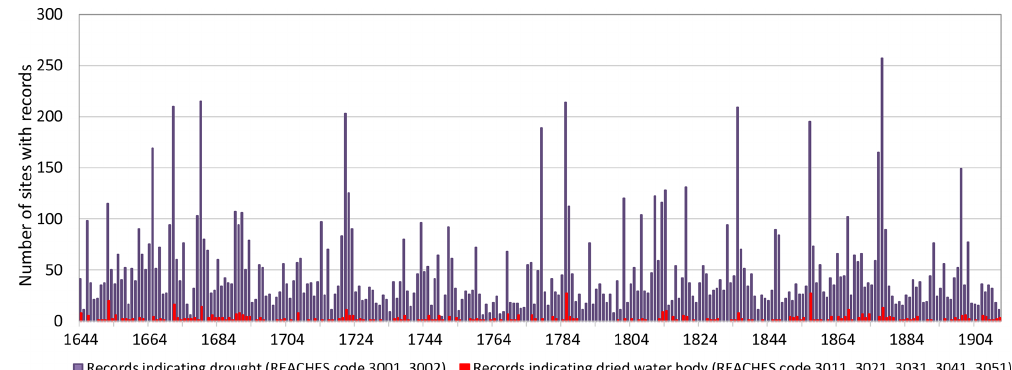
Figure 2. Comparison of drought records that indicate pure drought vocabularies (interpreted as meteorological drought) and dried water body (interpreted as hydrological drought).